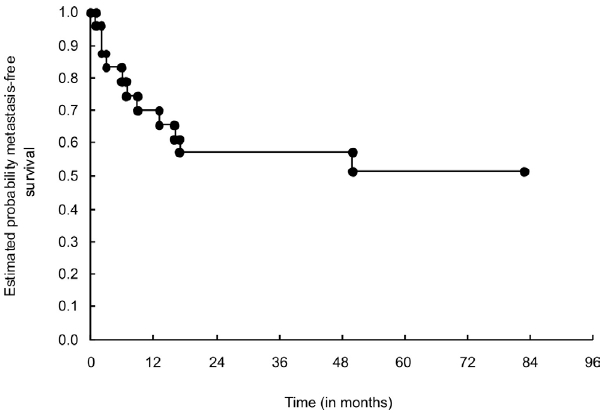
Figure 8 - Curve of metastasis-free survival in months for the 24 patients with primary osteosarcoma that was non-metastatic at